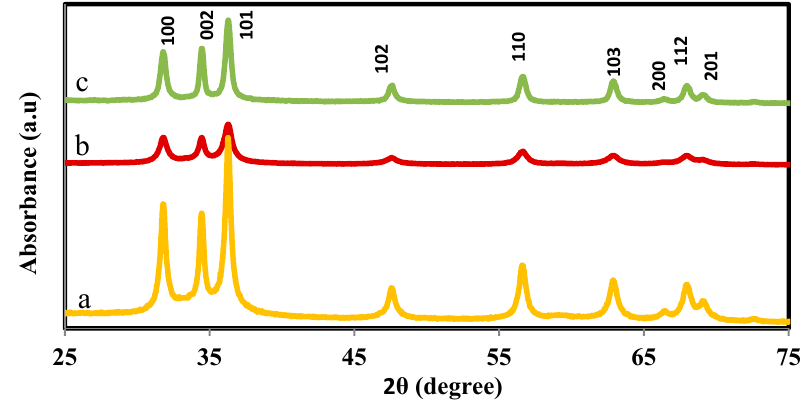
Figure 2. The XRD patterns of ( a ) ZnO fruit (ZnO-F), ( b ) ZnO seed (ZnO-S) and ( c ) ZnO pulp (ZnO-P) nanoparticles.